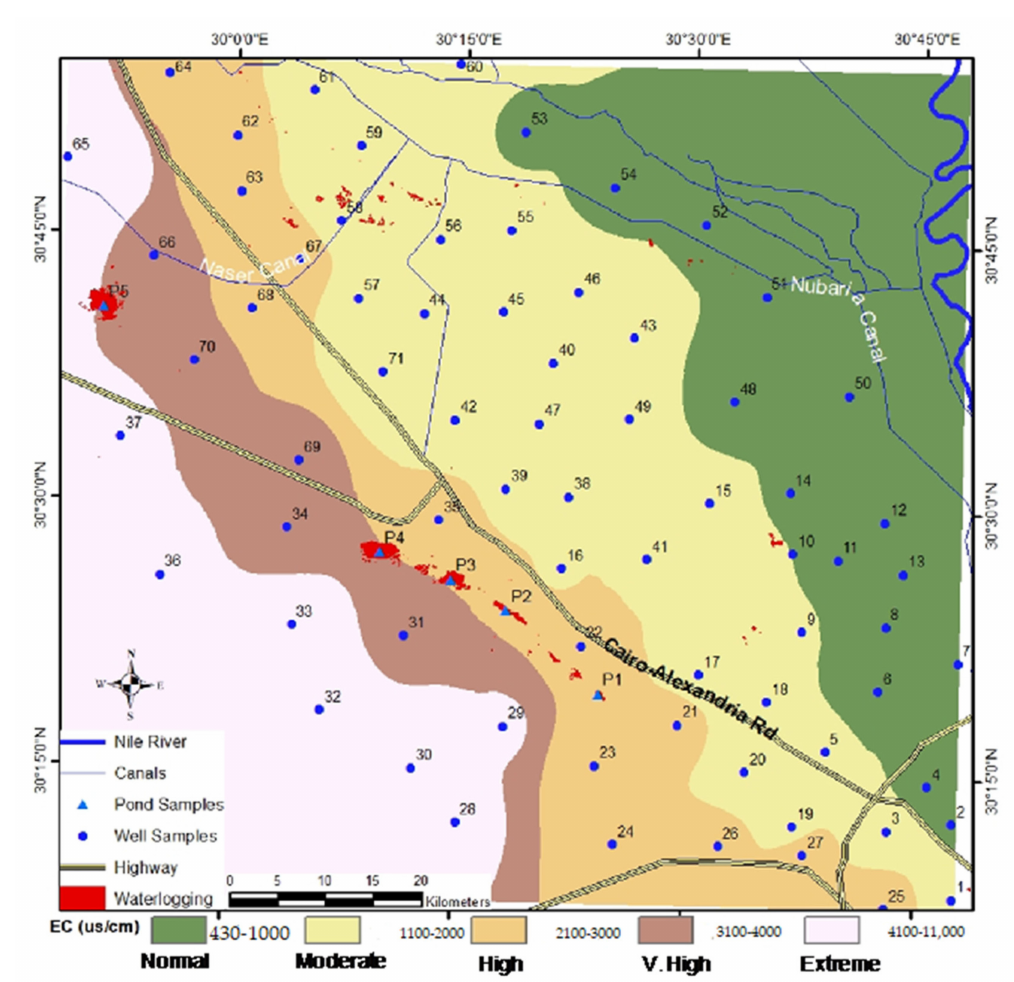
Figure 7. Geographical information system mapping (GIS) inverse distance weighted (IDW) interpolation of the groundwa- ter salinity based on the electrical conductivity (EC) µ